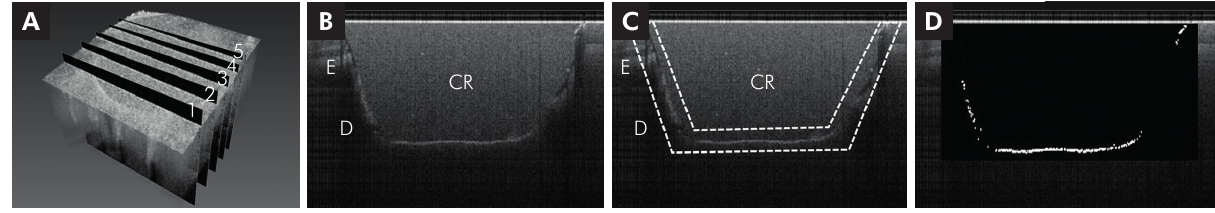
Figure 1. (a) Five 2D images were obtained from sample by OCT scanning at 500-µm intervals. (b) Representative 2D OCT image slice. (c) Standardized selection of the interfacial area with an increased signal value to be analyzed by the software. (d) The total percentage of brighter pixels, represented in white, over the entire interfacial zone was calculated using an ImageJ plugin ( i.e. 63% interfacial gap). The mean of five cross-sectional images were calculated per sample. Abbreviations: CR, composite resin; E, enamel; D,